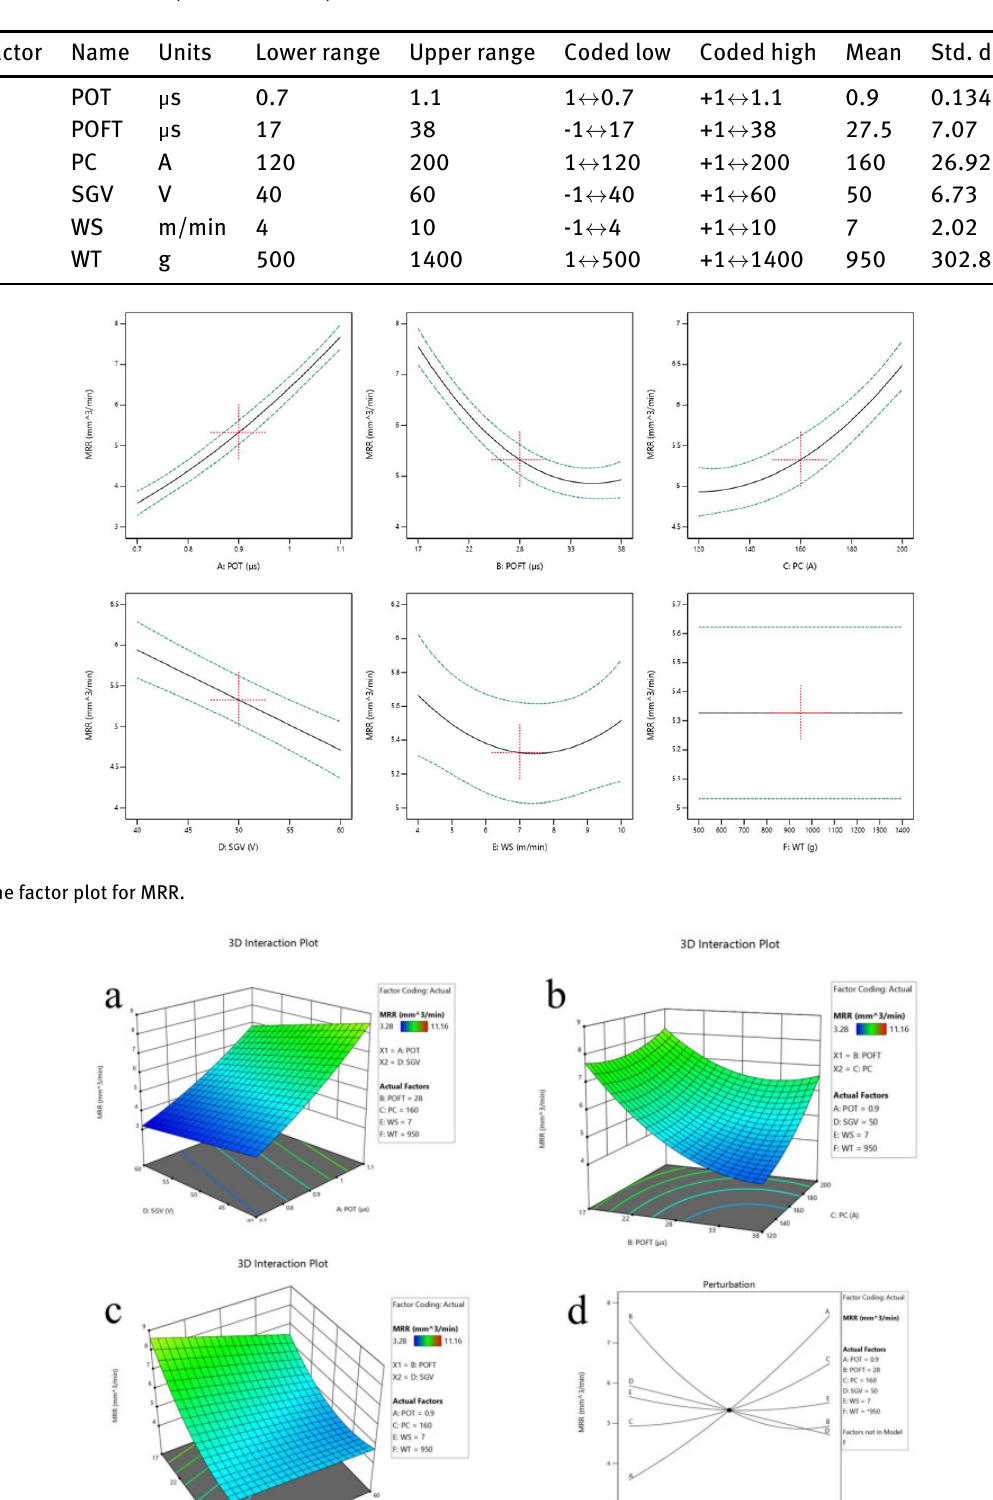
Table 1: Factors and their levels (coded and actual).